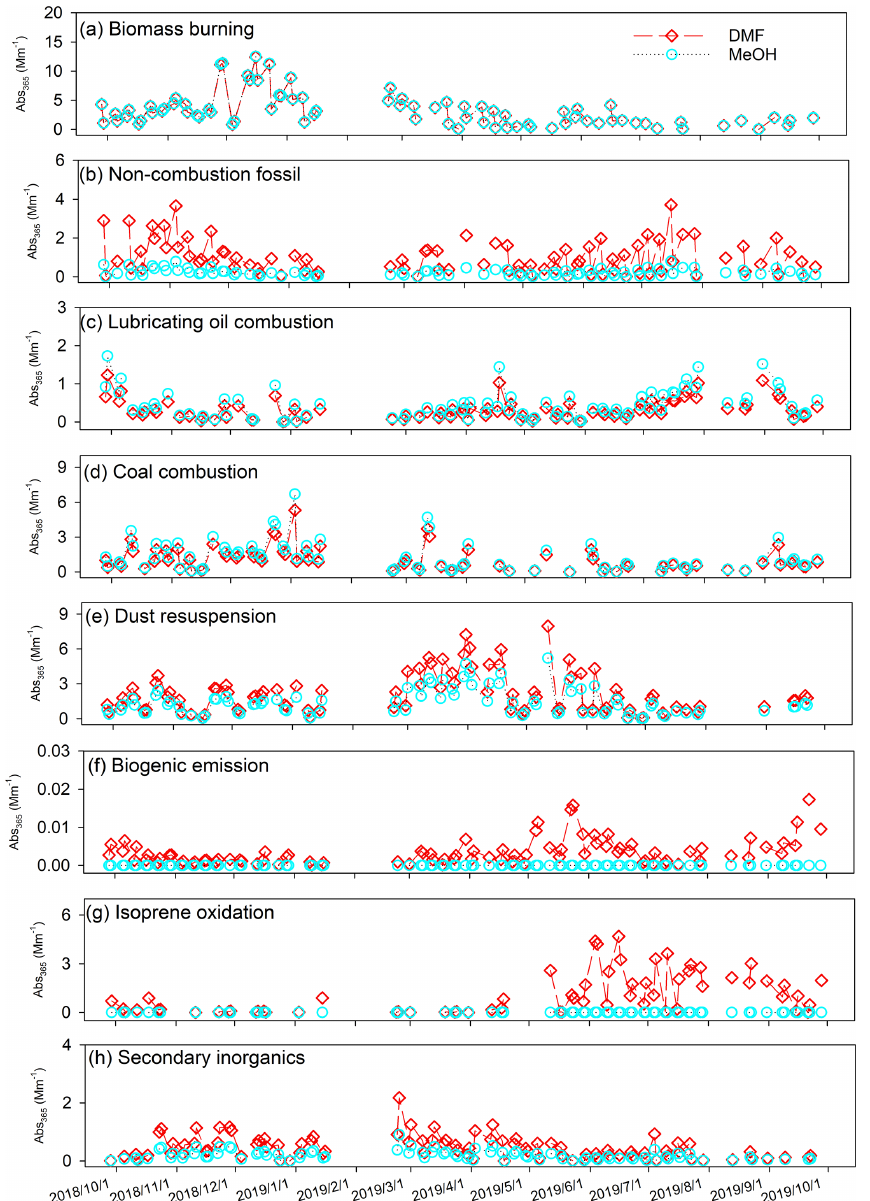
Figure 3. Time series of factor contributions to Abs 365 of DMF and MeOH extracts of ambient PM 2 . 5 samples.